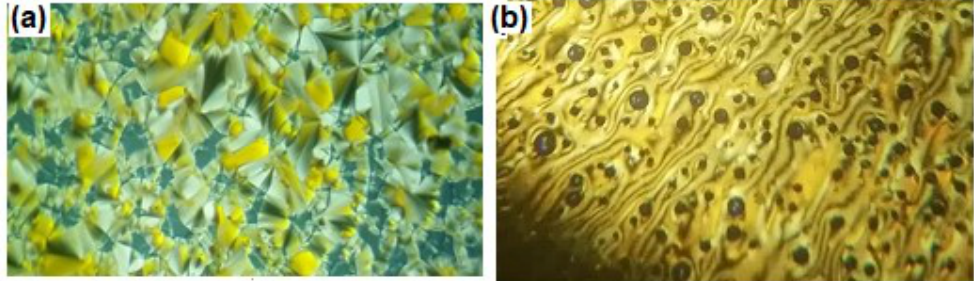
Figure 2. Polarized optical microscopy (POM) textures (the width of the images is about 40 µ m) of the binary mixture 40 mol% Ia for system Ia / Ib upon heating. ( a ) SmA phase at 86 ◦ C; ( b ) N phase at 108 ◦